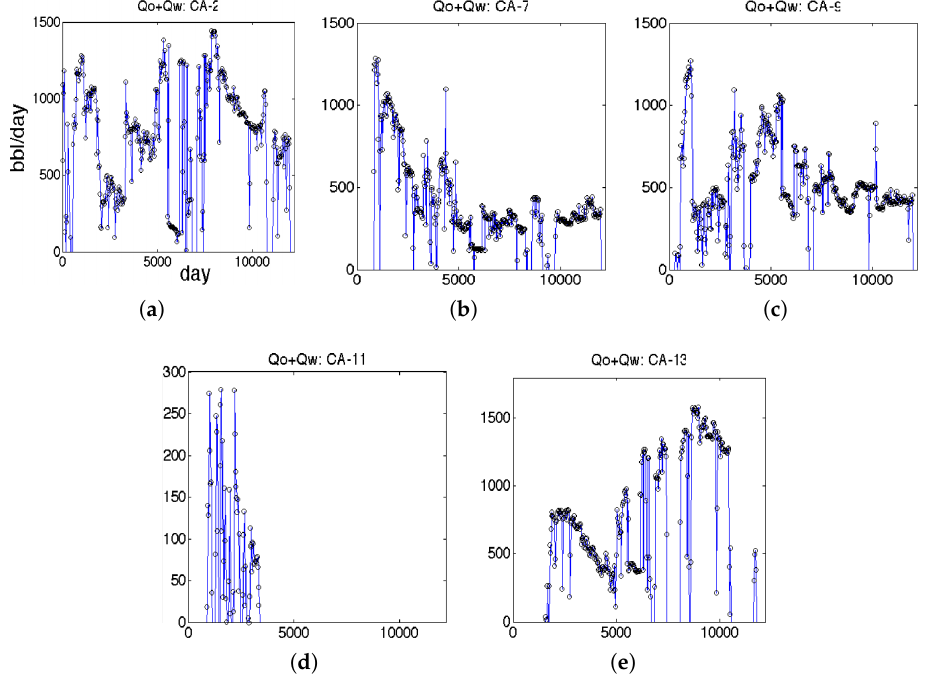
Figure 9. History of the modelled flow rates for five producers, C002 ( a ); C007 ( b ); C009 ( c ); C011a ( d ); C013 ( e ). These figures have been taken from [7].